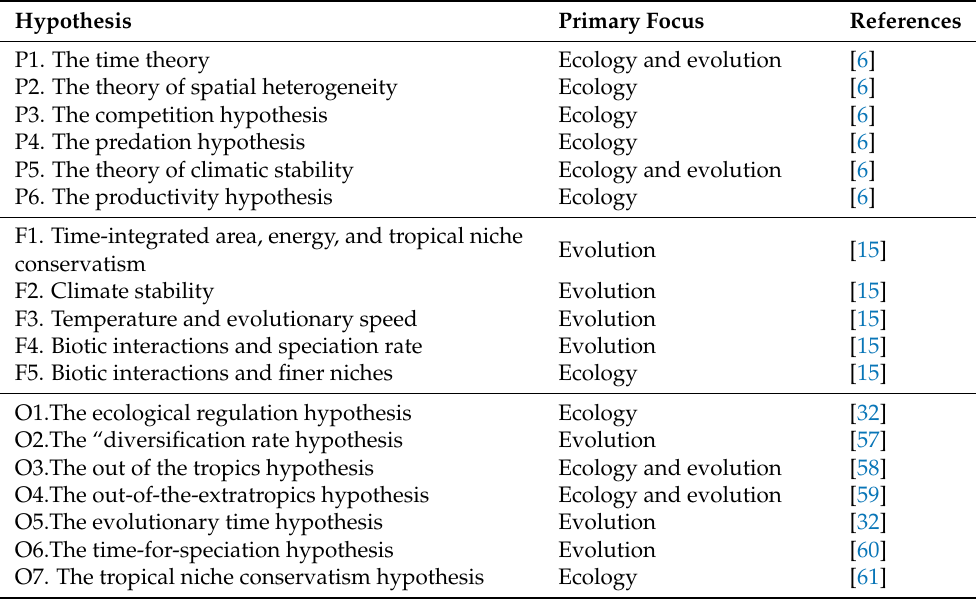
Table 1. Hypotheses from 1966 to 2021 for the latitudinal diversity gradient, P1–P6 from